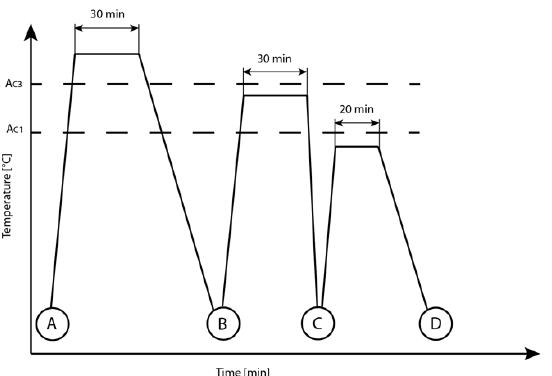
Figure 1. Schematic representation of the heat treatment stages: Full annealing (A,B), intercritical annealing and quenching (B,C), and tempering (C,D).